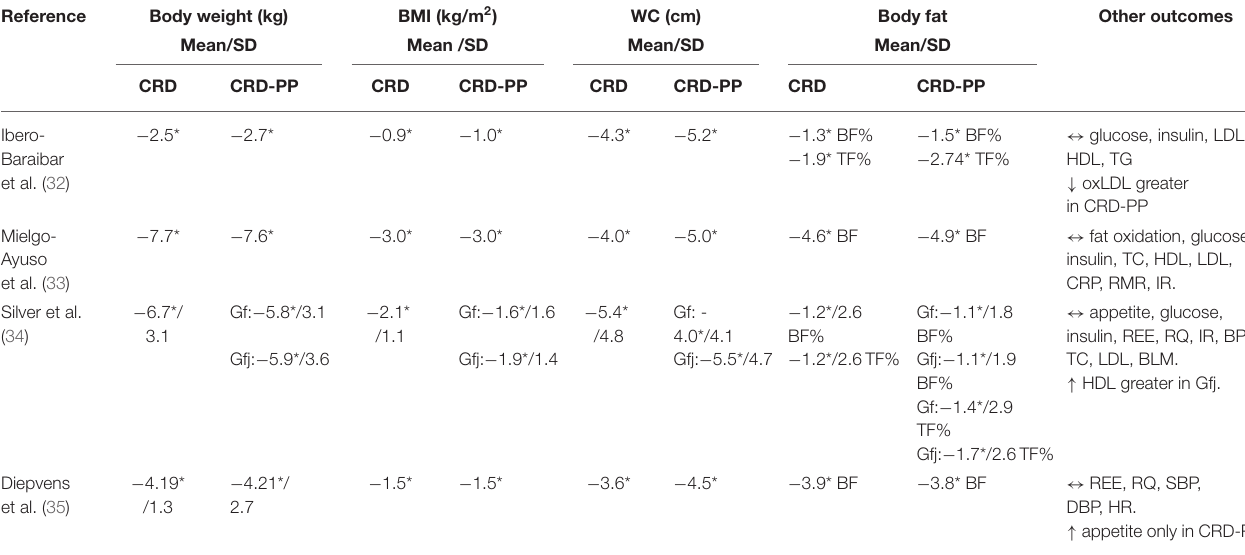
TABLE 3 | Changes of the outcomes after the intervention with calorie restricted diets and polyphenols. Reference Body weight (kg) BMI (kg/m 2 ) WC (cm) Body fat Other outcomes Mean/SD Mean /SD Mean/SD Mean/SD CRD CRD-PP CRD CRD-PP CRD CRD-PP CRD